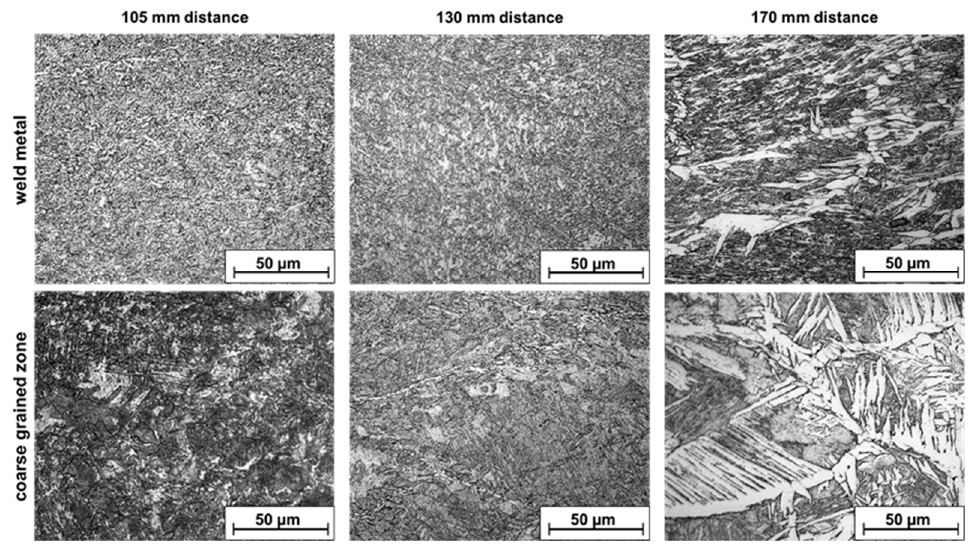
Figure 7. Microstructure development of the weld metal and the coarse-grained HAZ by varying the torch to roller distance.